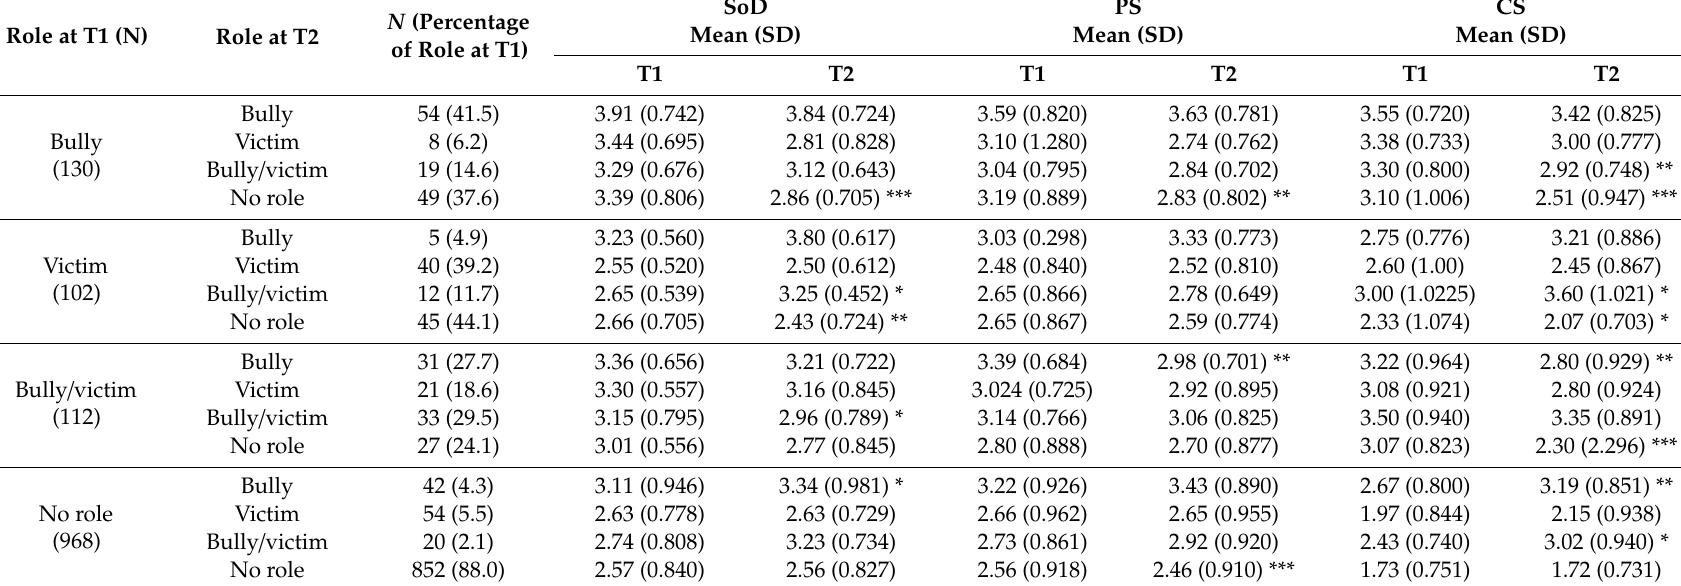
Table 5. Bullying role changes from T1 to T2 and SD, PS, and CS means (standard deviations) at T1 and T2 by each role change. The cells indicated with bold style show significant mean di ff erences between T1 and T2. Significance level is shown in the cell at T2: * p < 0.05, ** p < 0.01, *** p < 0.001.